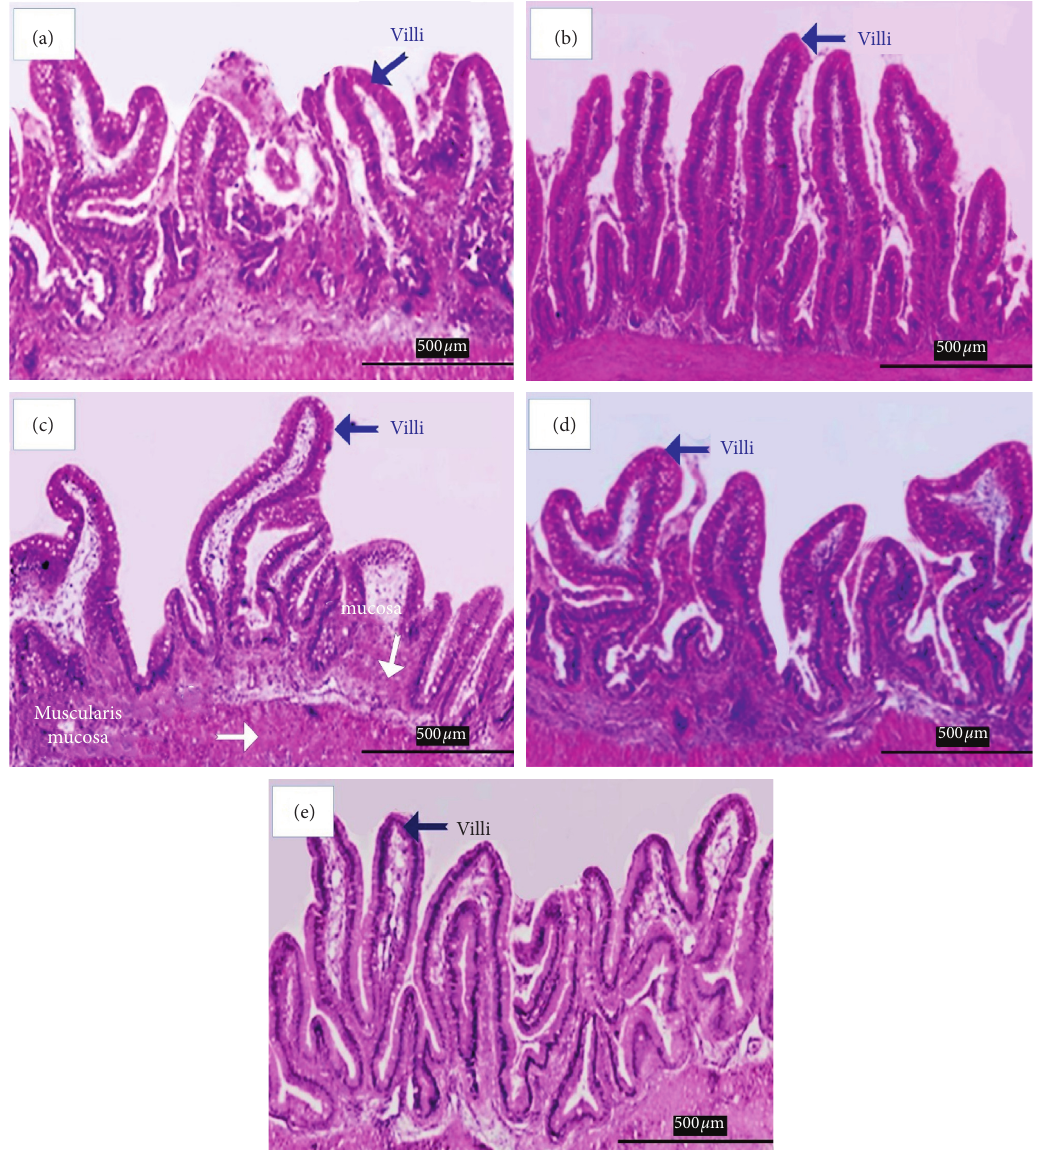
Figure 14: (a) Cyprinus carpio fed varied doses of Aloe vera and histology of distal intestine studied in control group A (0mg/kg) diet-fed group after 90 days of feeding trial. (b) Cyprinus carpio fed varied doses of Aloe vera and histology of distal intestine studied in treatment group B (200mg/kg) diet-fed group after 90 days of feeding trial. (c) Cyprinus carpio fed varied doses of Aloe vera and histology of distal intestine studied in treatment group C (400 mg/kg) diet-fed group after 90 days of feeding trial. (d) Cyprinus carpio fed varied doses of Aloe vera and histology of distal intestine studied in treatment group D (800mg/kg) diet-fed group after 90 days of feeding trial. (e) Cyprinus carpio fed varied doses of Aloe vera and histology of distal intestine studied in treatment group E (1600mg/kg) diet-fed group after 90 days of feeding